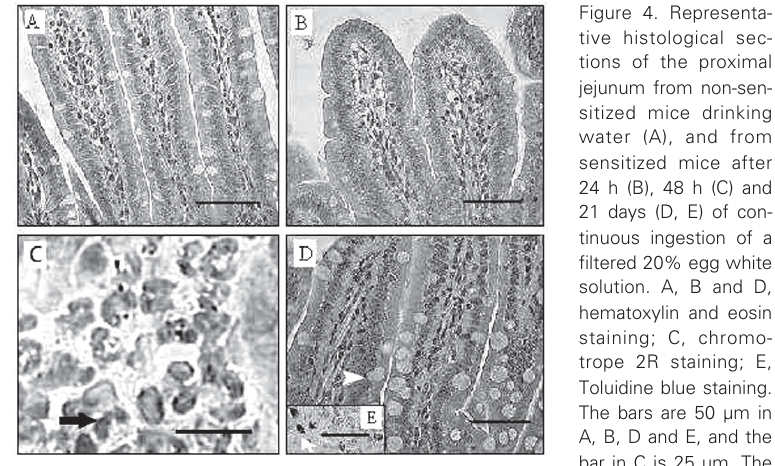
large arrow in C indicates an eosinophil, the small white arrow in E indicates a mast cell, and the white arrowhead in D indicates a goblet cell.